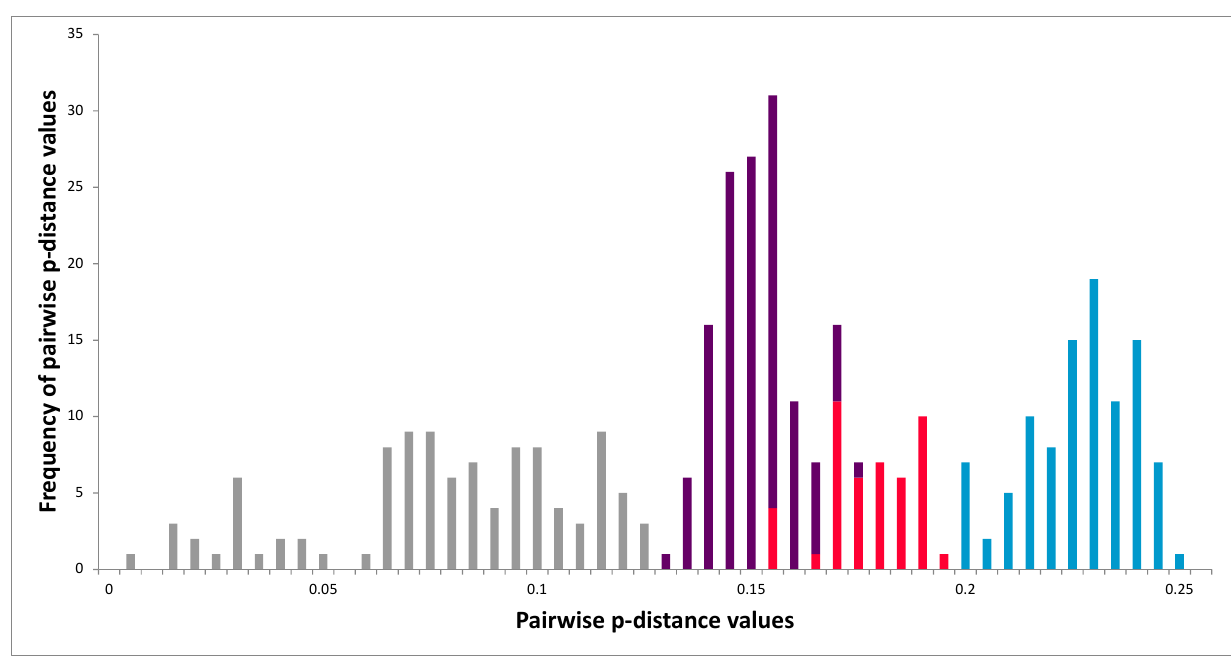
Figure 6. Frequency of the pairwise p-distance values of the 3D pol nucleotide sequences generated by MEGA. Bar colors correspond to sequences and clusters as in Figure 5.